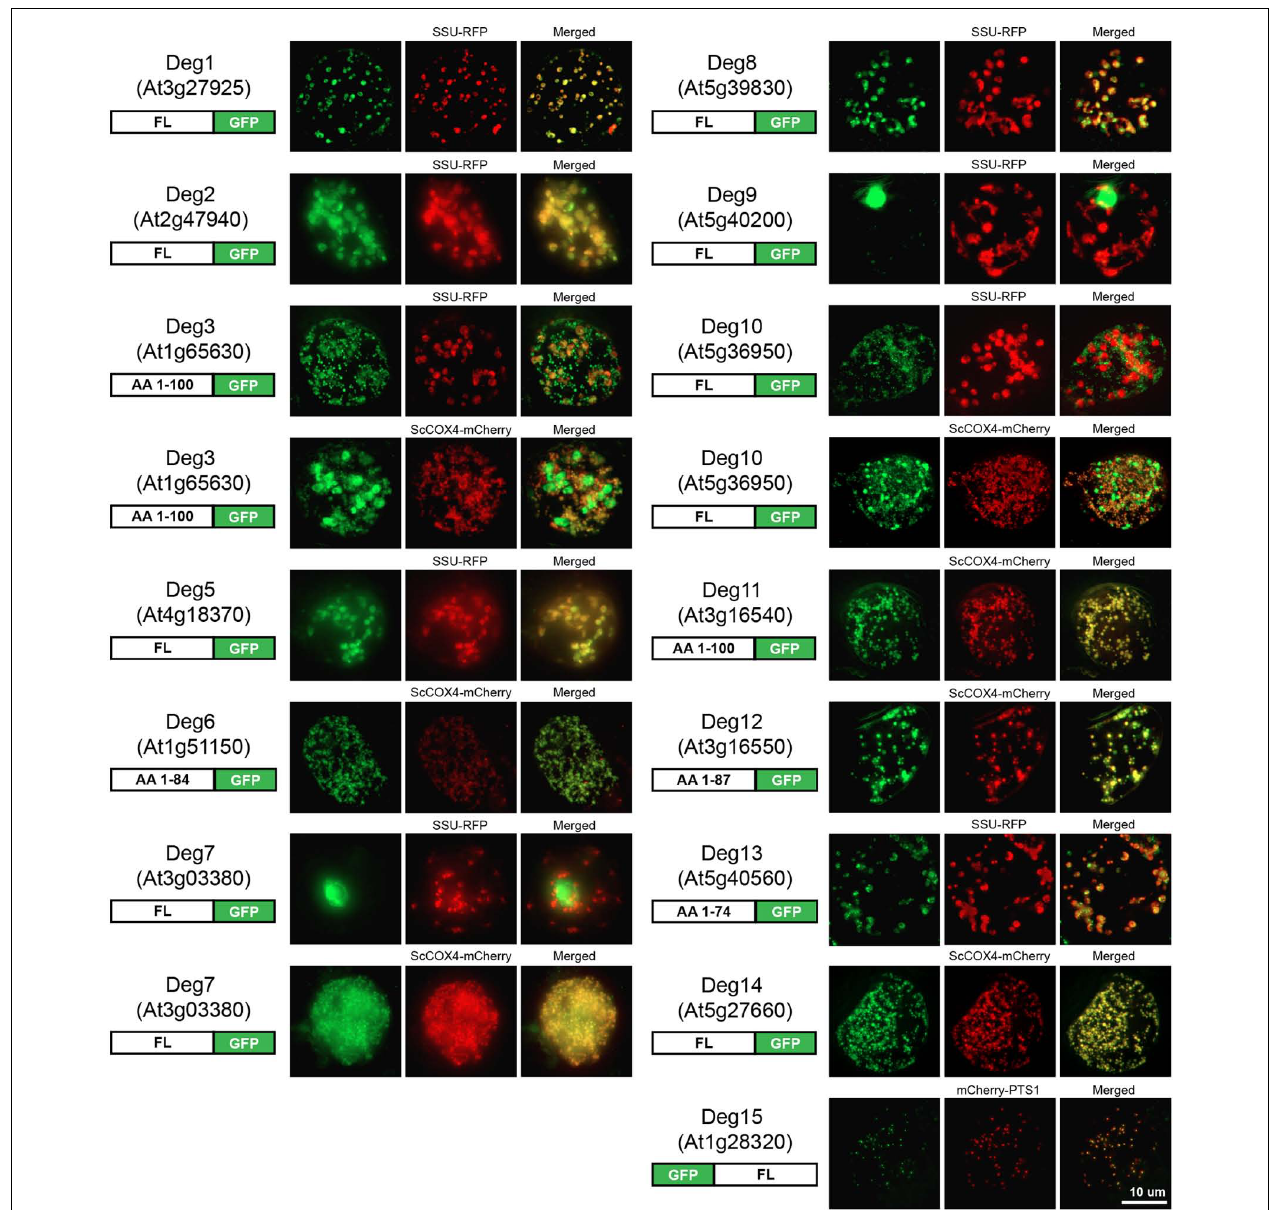
FIGURE 3 | Fluorescence images of the subcellular localization of Deg proteases by GFP tagging. N - and/or C -terminal GFP fusion proteins were constructed. Either the full-length (FL) or part of the protein with the number of amino acids (AA) indicated in the schematic representation of each construct (left) were fused to GFP. Targeting ability was tested in Arabidopsis suspension cells using SSU-RFP as a marker for plastid